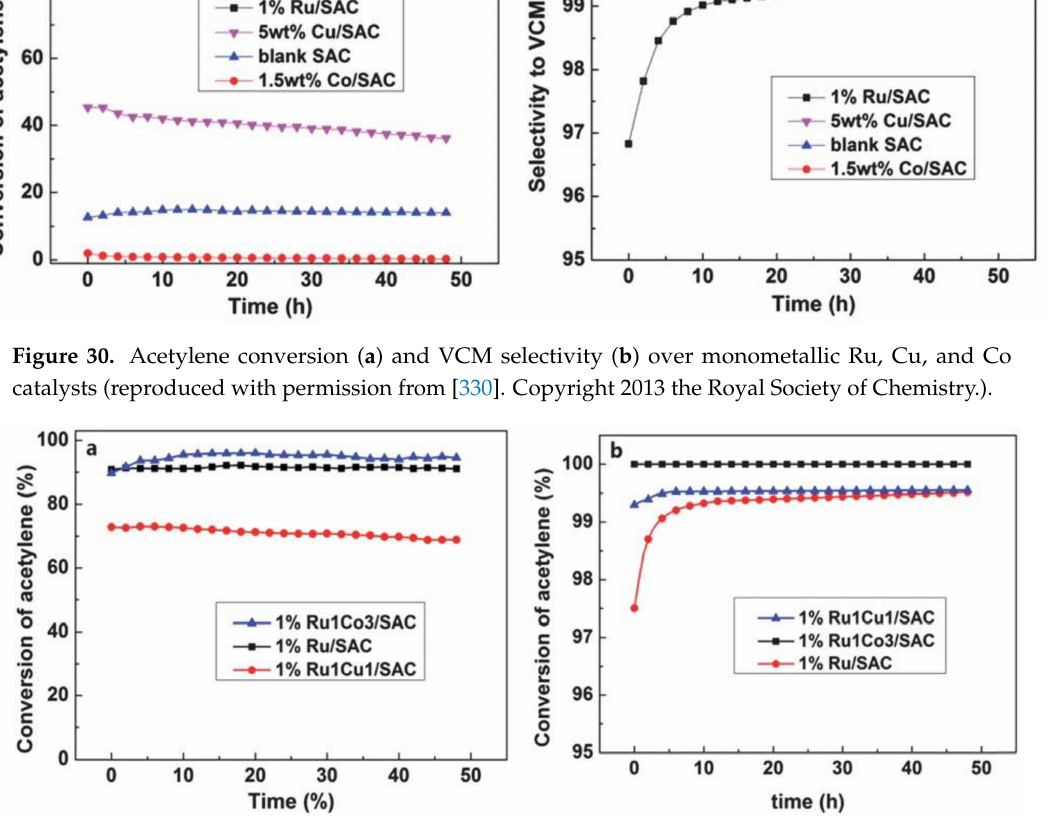
Figure 31. Acetylene conversion ( a ) and VCM selectivity ( b ) over 1%Ru, 1%Ru1Cu1, and 1%Ru1Co3 catalysts (reproduced with permission from [330]. Copyright 2013 the Royal Society of